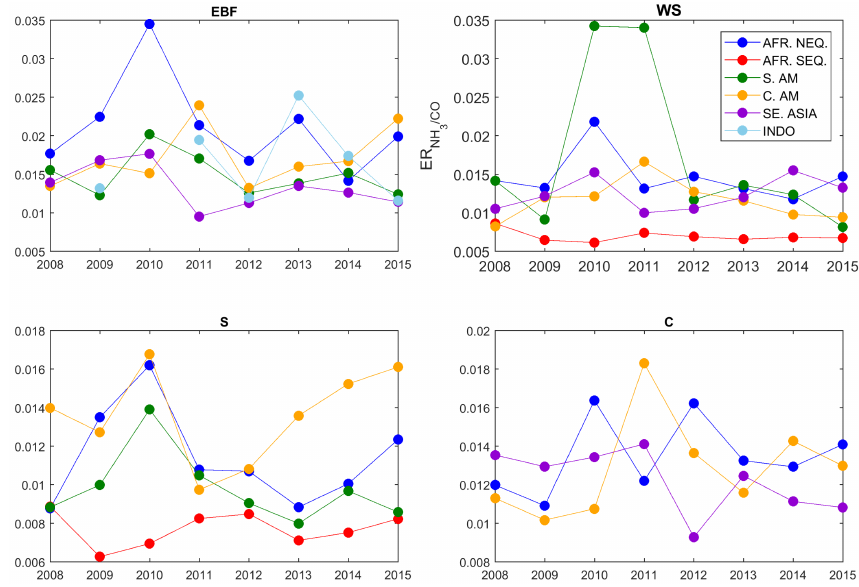
Figure 7. Mean biome-specific ER NH ratios averaged by year (2008–2015) and by region (colored dots and lines) from the yearly 3 / CO ER NH ratios calculated for the pixels selected in Sect. 2.3. From top left to bottom right: EBF, WS, S, and 3 / CO